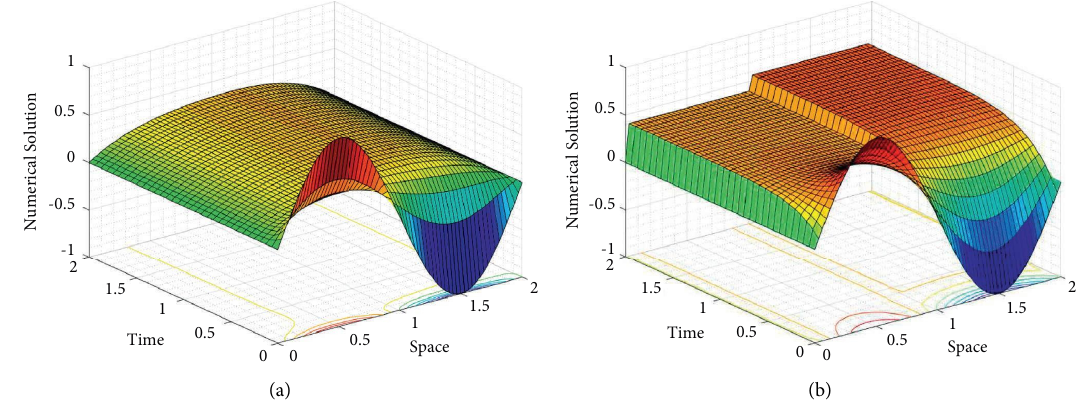
Figure 2: Surface plots for the numerical solution of Example 1 for N � 128 and M � 64. (a) [ ε � 2 0 ], (b) [ ε � 2 − 16 ].